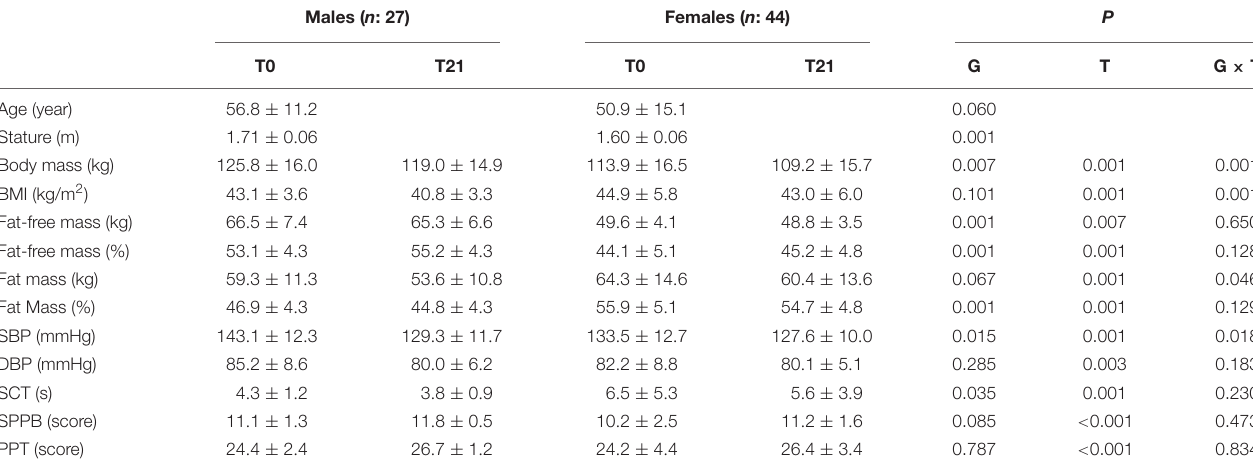
TABLE 3 | Physical characteristics of adults with obesity before (T0) and after (T21) the 3-week BWRP. Males ( n : 27) Females ( n :